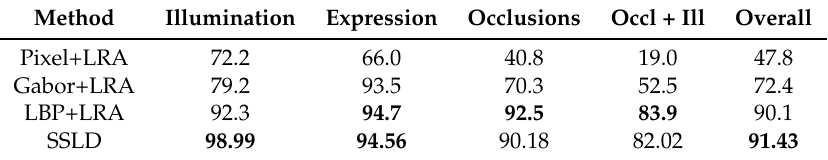
Table 4. Experiments on AR dataset and comparison with [15]. For each category we report the recognition rate on both sessions and the overall accuracy. In bold we highlight the best